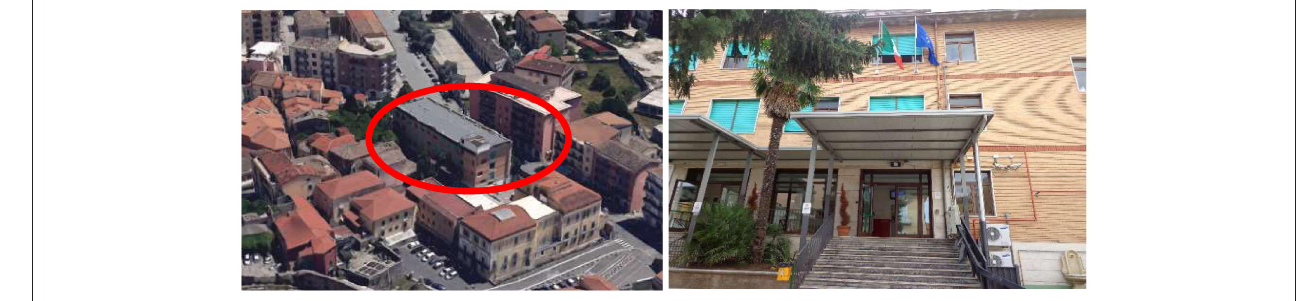
FIGURE 1 | View of the case study building.